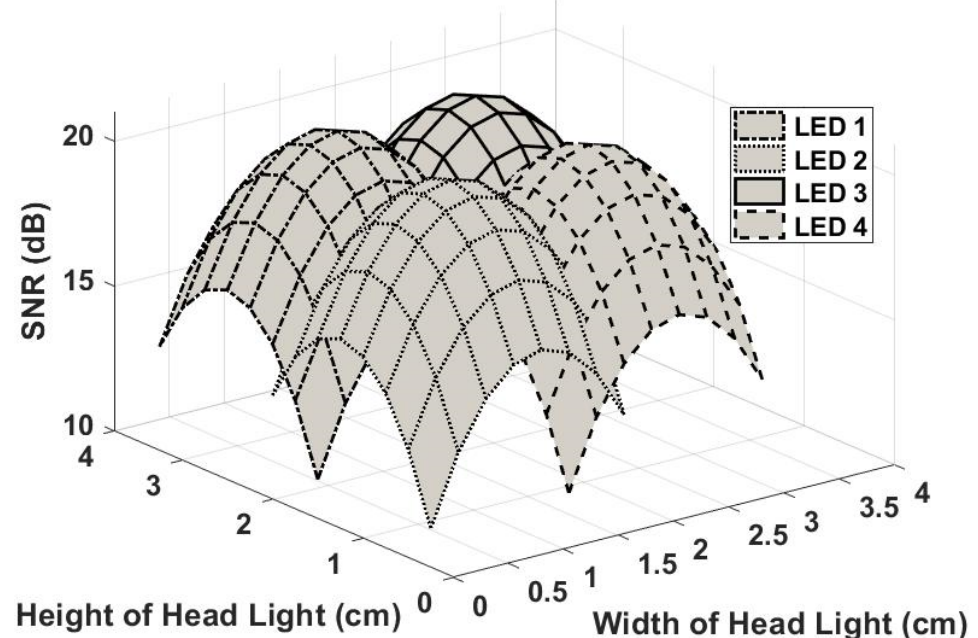
Figure 4. Estimated SNR for the four LED units.